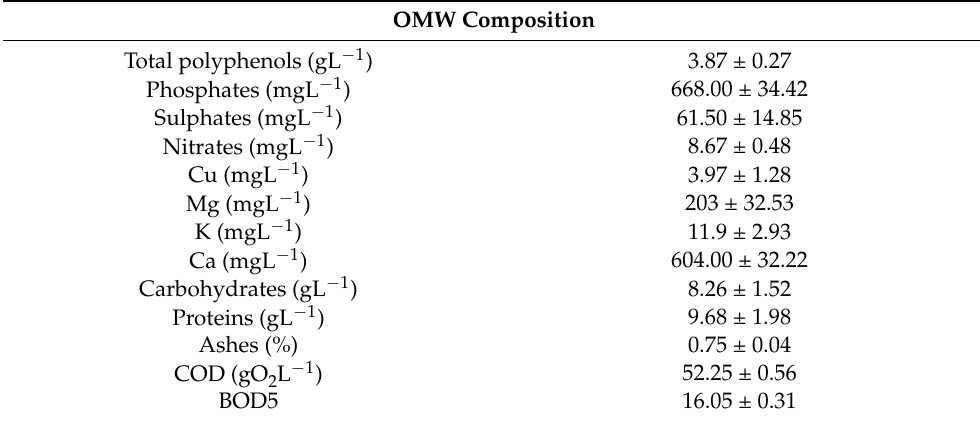
Table A1. Chemical composition of Olive Mill Wastewater (OMW) used for costmary